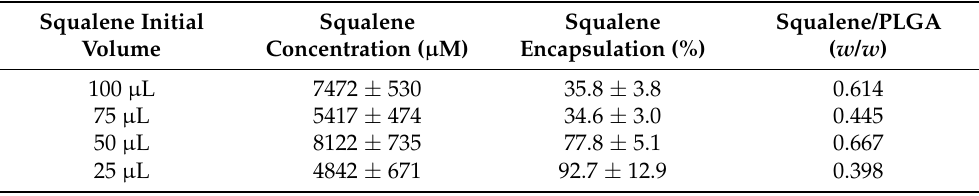
Table 1. Squalene content and encapsulation based on the squalene initial volume in PLGA nanoparticles.